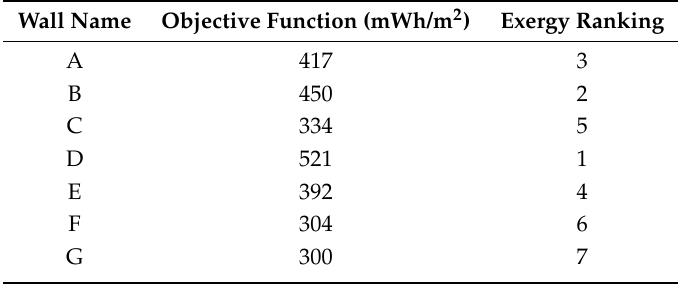
Figure 10. Objective function (10 air changes per hour (ACH), 17/08). Table 2. Numerical values of Figure 10.